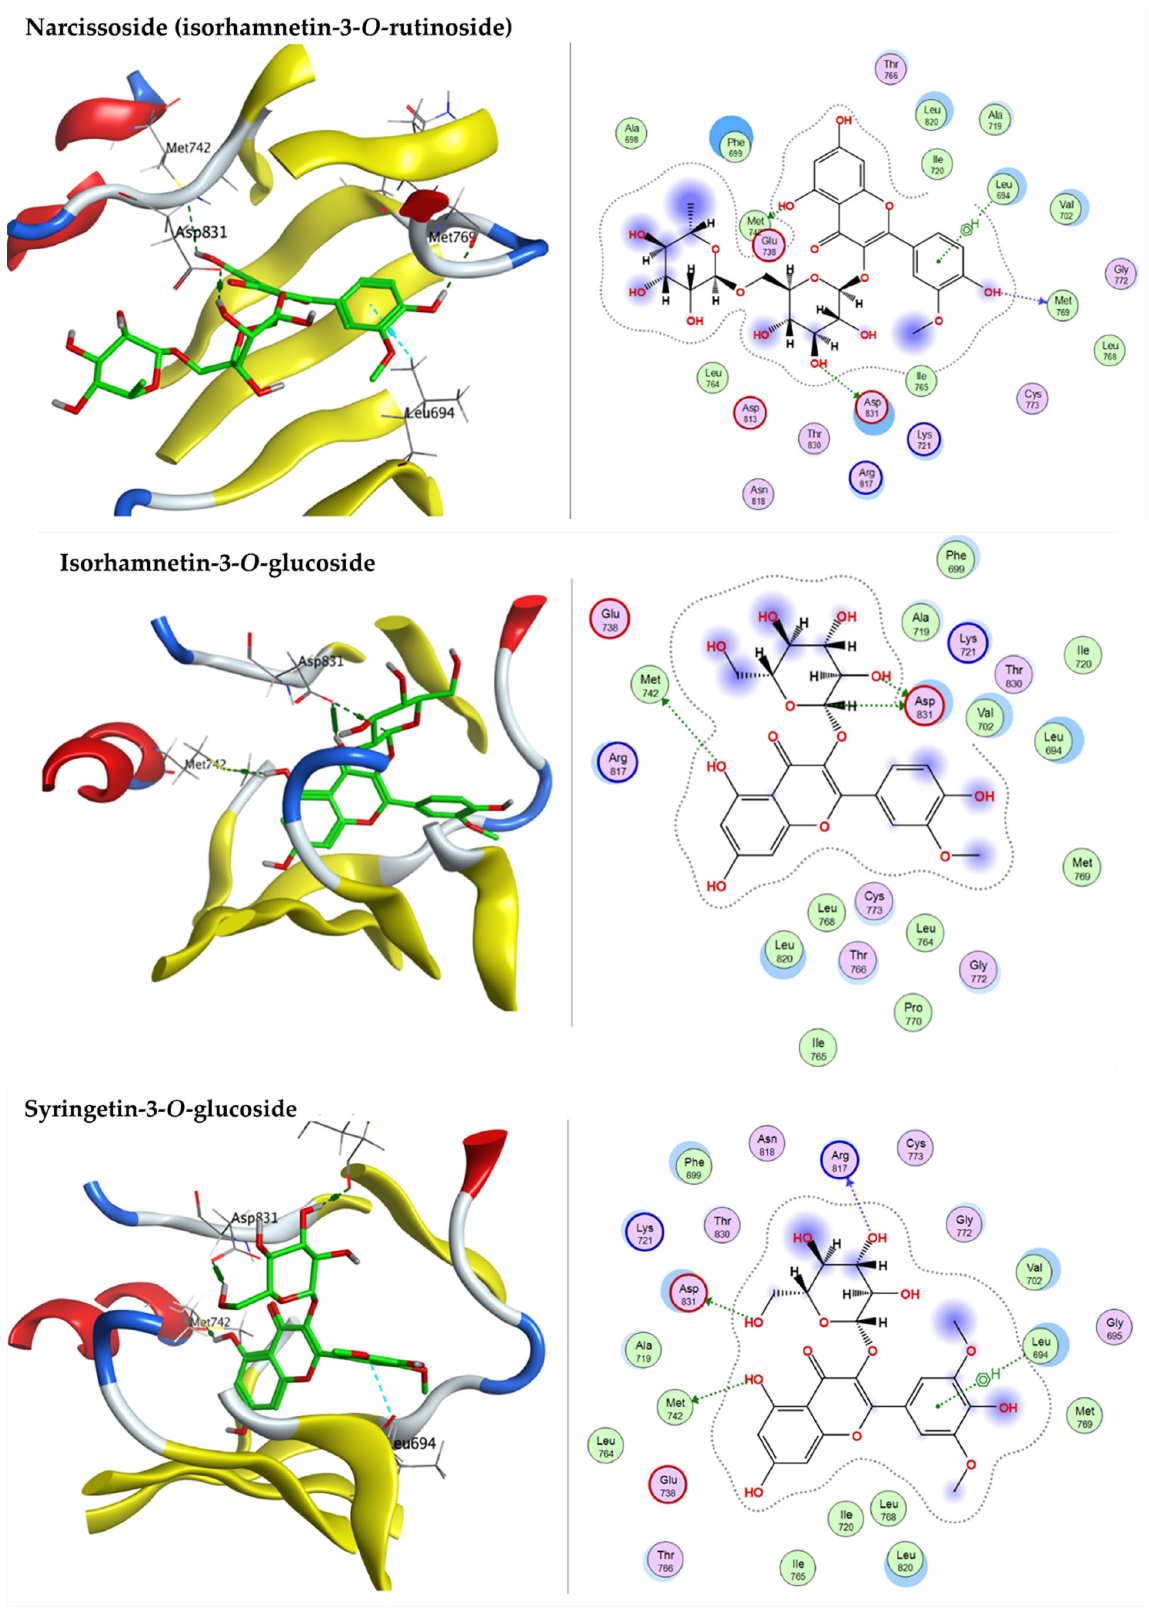
Figure 9. 3D and 2D docking plots of narcissoside (isorhamnetin ‐ 3 ‐ O ‐ rutinoside), isorhamnetin ‐ 3 ‐ O ‐ glucoside, and syringetin ‐ 3 ‐ O ‐ glucoside, respectively, on EGFR (PDB code: 1M17).